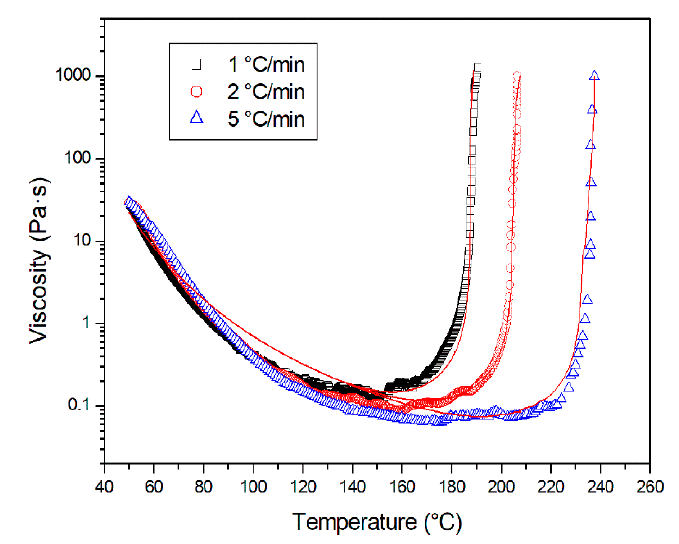
Figure 8. Viscosity plots for the PRISM EP 2400 resin at different heating rates. The red line represents the fitting according to the modified Kenny and Opalicki model.